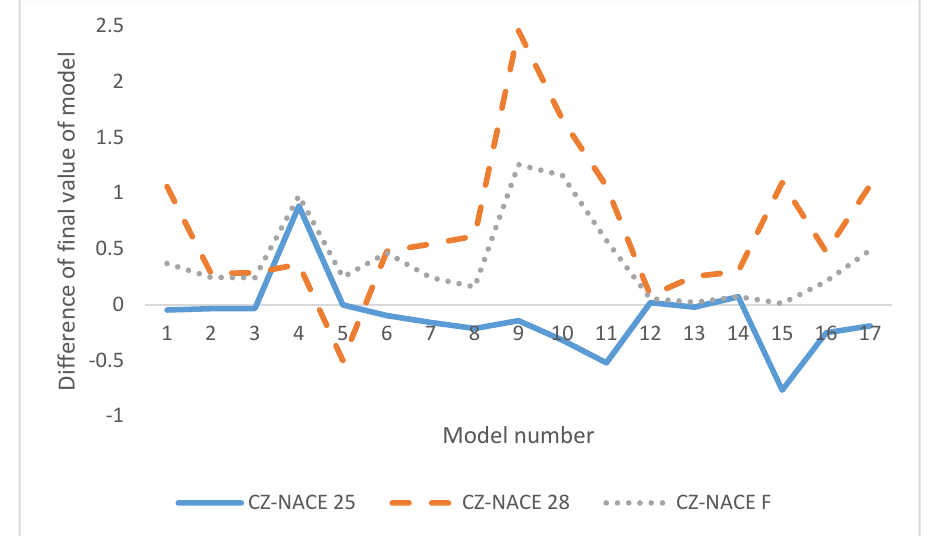
Figure 3. Absolute differences of the model indicators for healthy companies regarding 2012 and 2017 by branches. Source: authors’ own work.